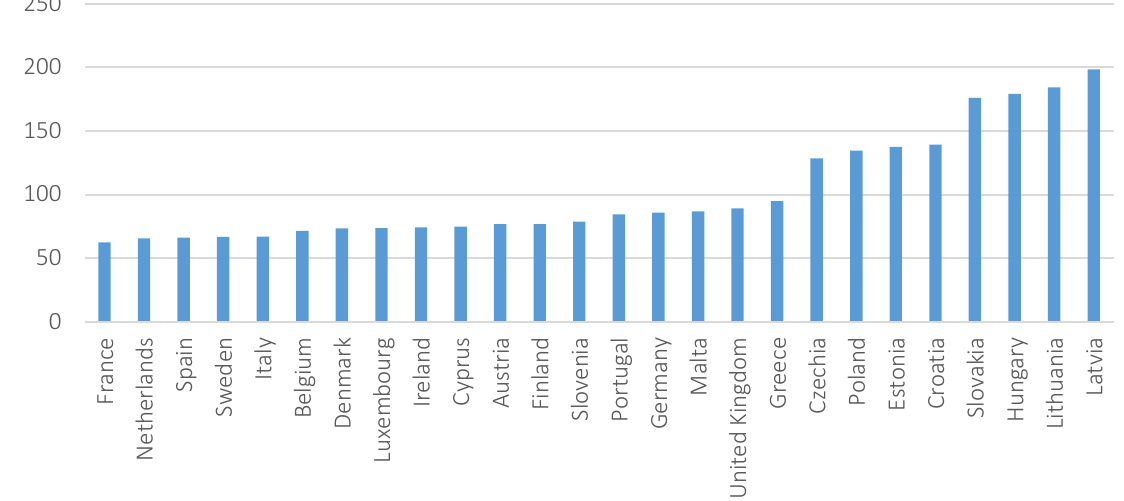
050100150200250 Figure 2. Amenable mortality (standardized death rate per 100 000 inhabitants) of selected countries